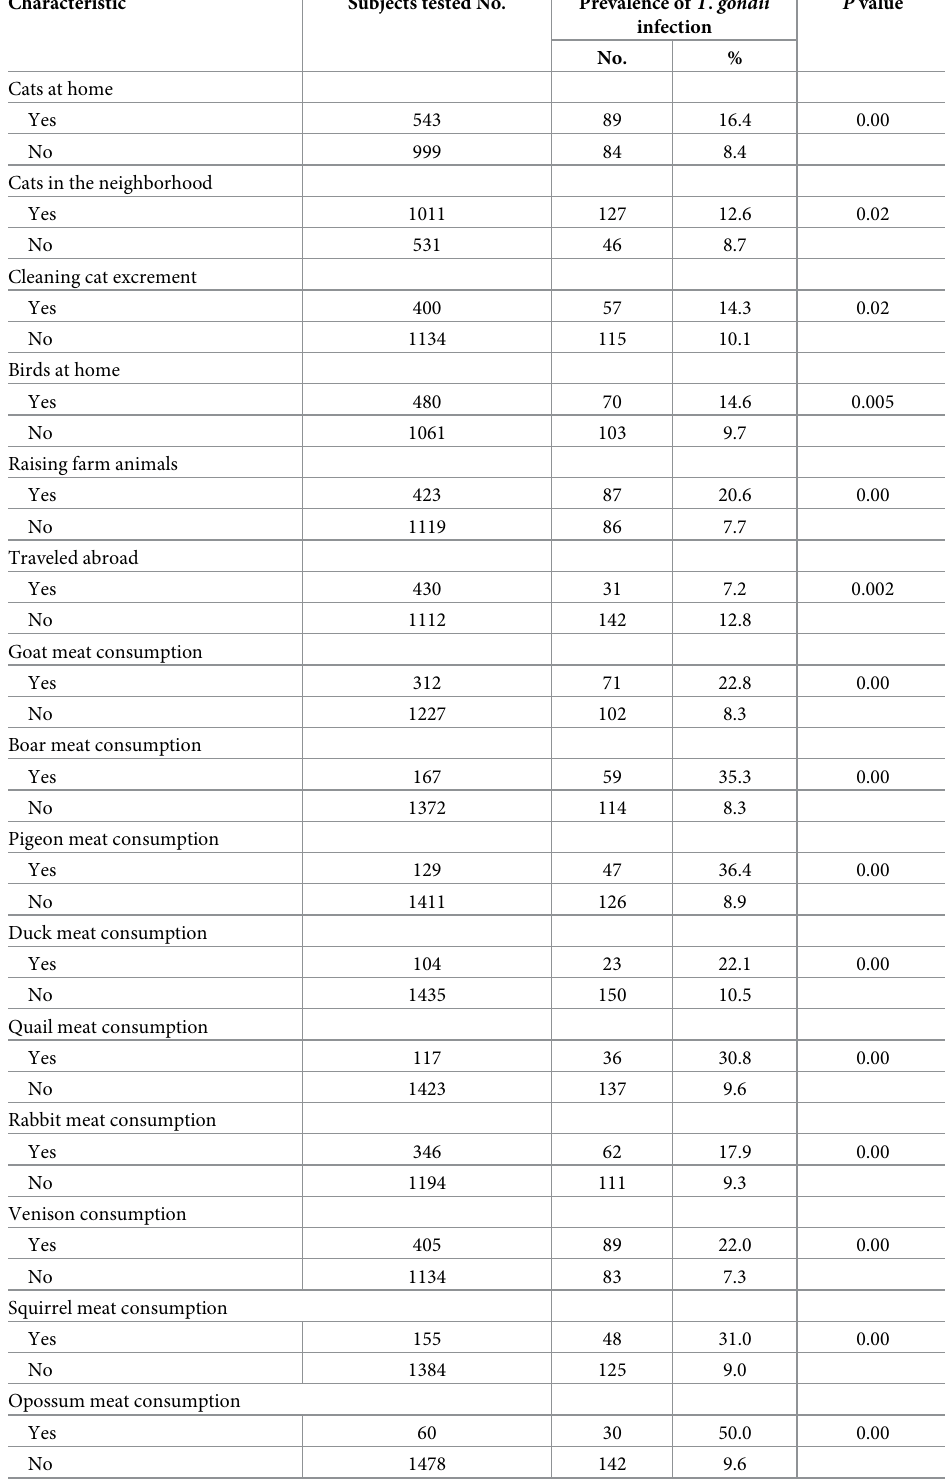
Table 3. Bivariate analysis of selected behavioral factors and infection with T . gondii in the population studied. Characteristic Subjects tested No. Prevalence of T . gondii